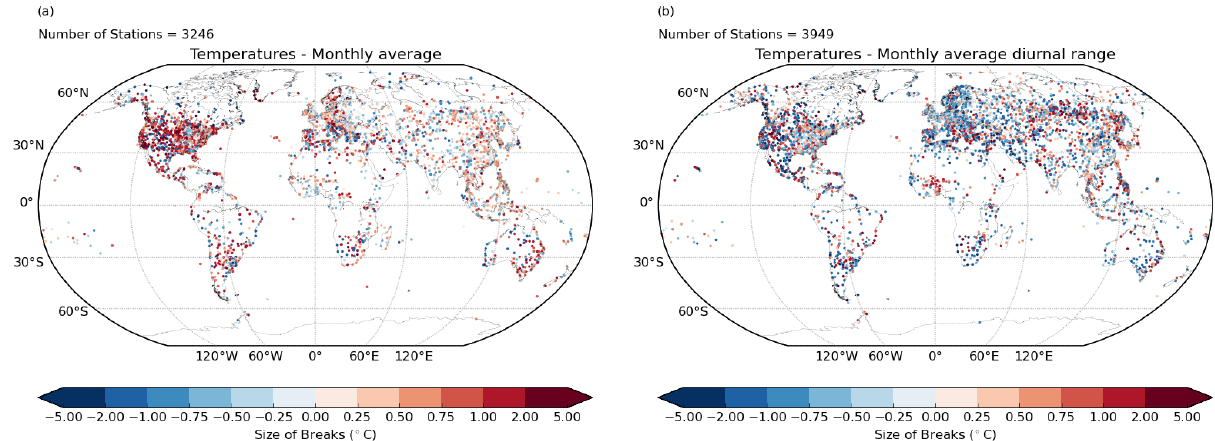
Figure 6. The distribution of the largest absolute inhomogeneity found for each station when using the (a) monthly-mean temperature and (b) the monthly-mean diurnal temperature range. Only those stations which have at least one change point are shown, resulting in the different numbers of stations for each panel. Note the non-linear colour scale.